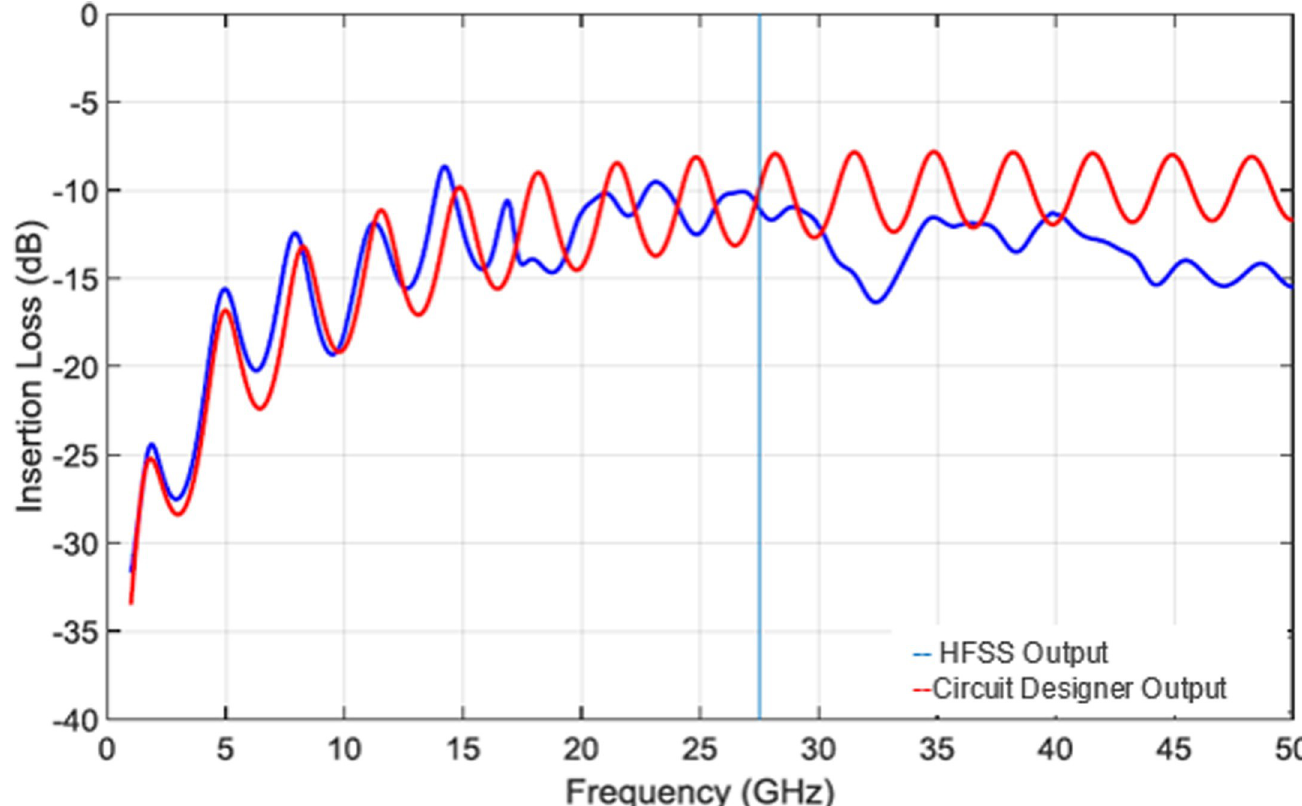
Fig 8. Comparison of Circuit Design and HFSS Design for the same structure when P1_28 GHz is active.